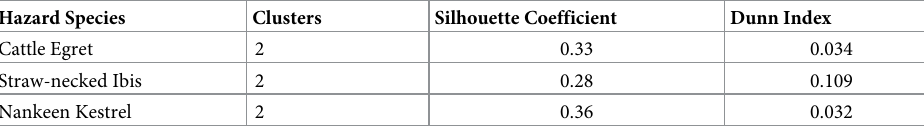
Table 4. Cluster validation measures by hazard